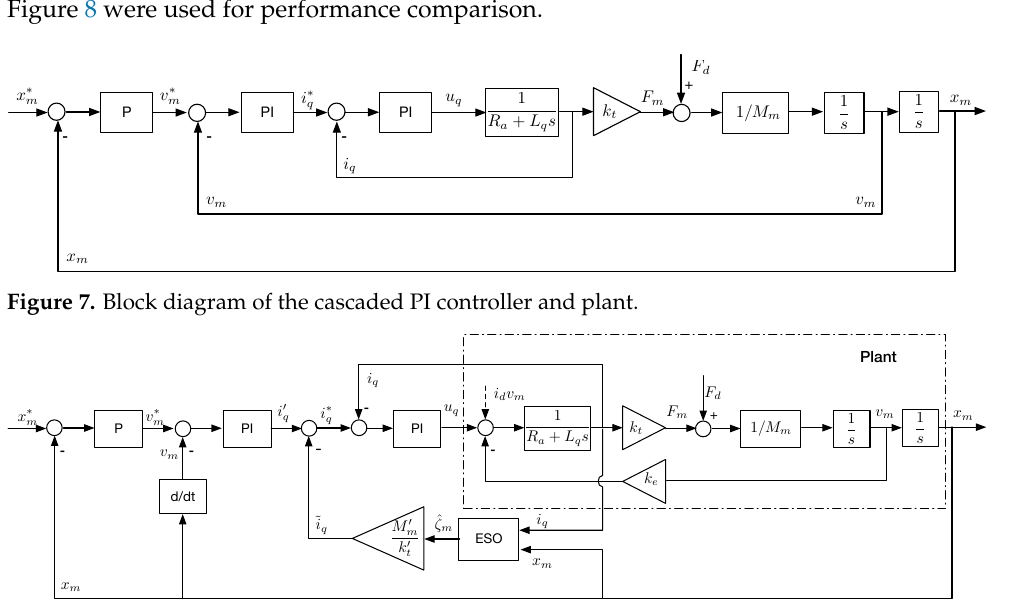
Figure 8. Block diagram of the extended state observer-based controller and plant. For the cascaded control structure, the time scale of the current loop was the fastest. The bandwidth of the inner loop needed to be 5–10 times larger than the outer